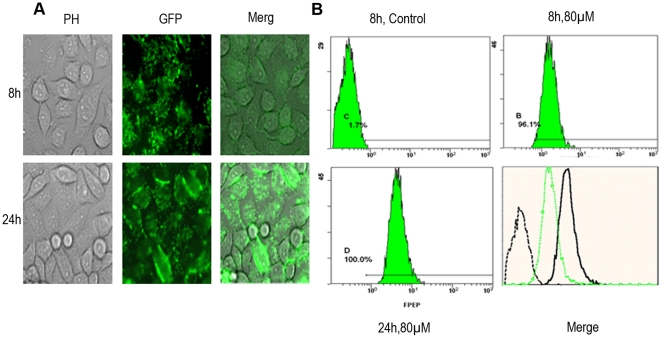
Cell-uptaking and Intracellular Location of the Selected Peptide.SiHa cells were observed under a fluorescence microscope (A) (scale bar: 50 µm) or analyzed by FCS (B) after 8 h or 24 h of incubation with 80 µM green fluorescent labeled F-pep.